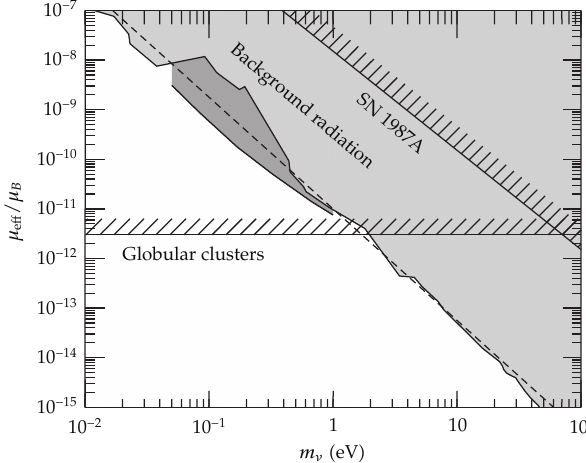
Figure 3: Astrophysical limits on neutrino transition moments (cid:5) 117, 118 (cid:6)